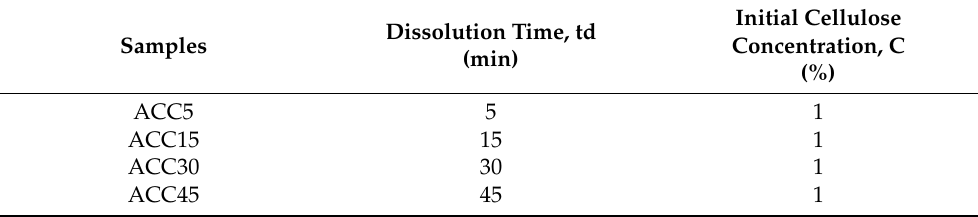
Table 1. Formulation of the all-cellulose composite films in the present work under different conditions.